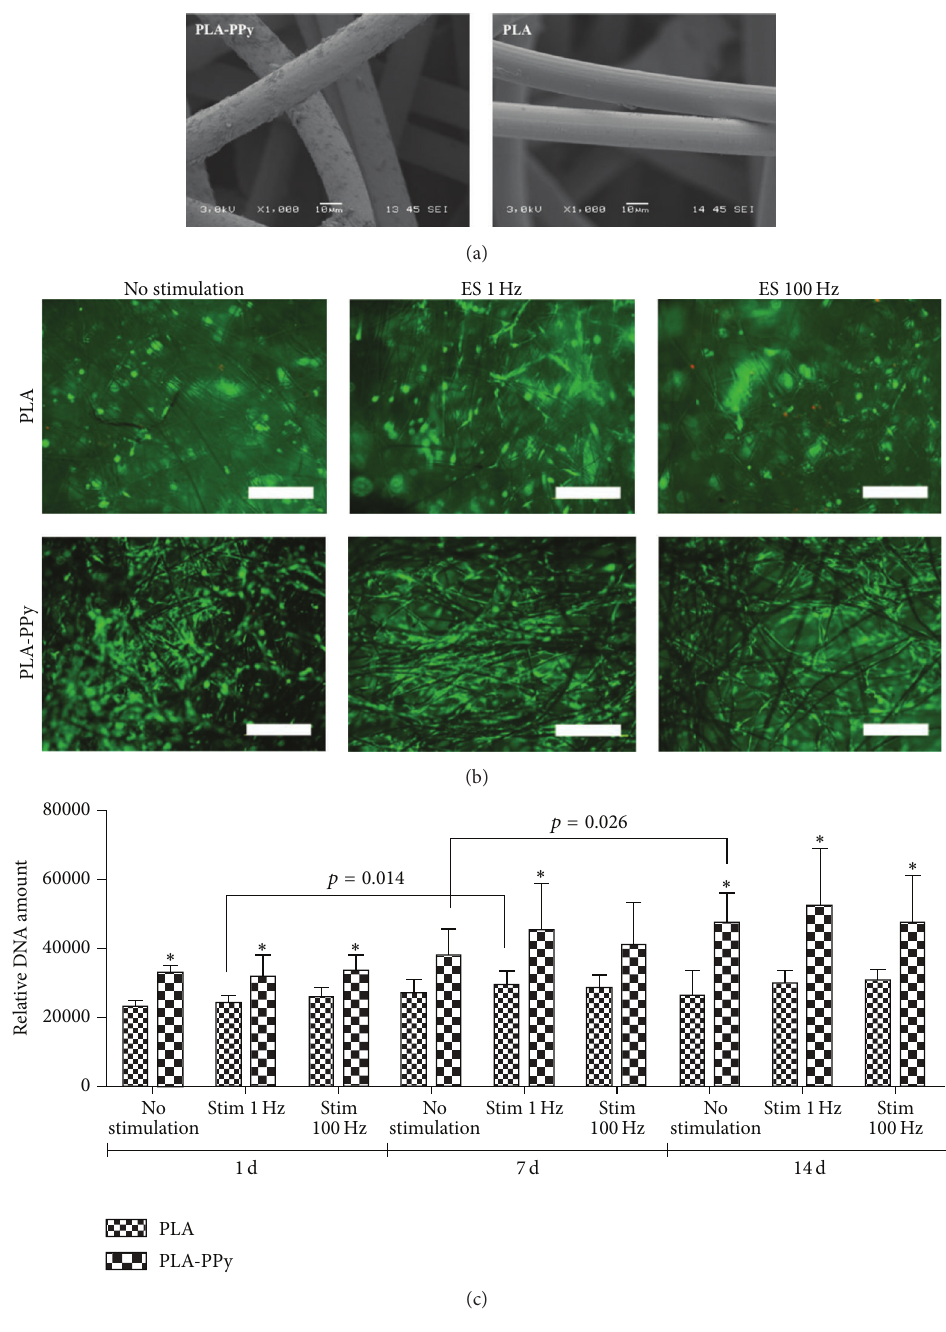
Figure 1: PPy-coated PLA scaffolds are able to enhance ASC proliferation through electrical stimulation. (a) Scanning electron microscopy image of PLA-PPy scaffold (left) without sputtered gold layer and PLA scaffold (right) with 20nm gold coating. (PLA scaffold could not be imaged without coating due to the heavy electrostatic.) (b) Representative images of the viable (green) and dead (red) ASCs seeded in PLA and PLA-PPy scaffolds at day 14 (scale bar: 500 𝜇 m). (c) Relative DNA content of ASCs cultured for 1, 7, and 14 days in PLA and PLA-PPy scaffolds (in the form of mean ± standard deviation, 𝑛 = 3 , ∗ 𝑝 < 0.05 ) (adopted from